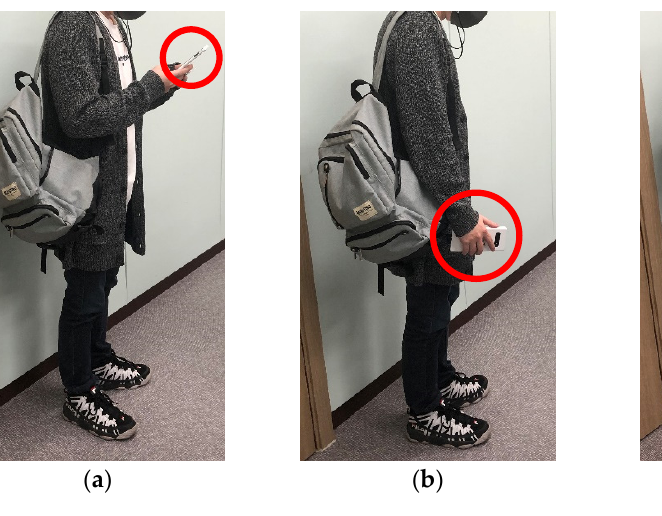
Figure 9. 4 data collect situations ( a ) hand held ( b ) hand swing ( c ) in pocket ( d ) back pack. Table 1. Deep learning model